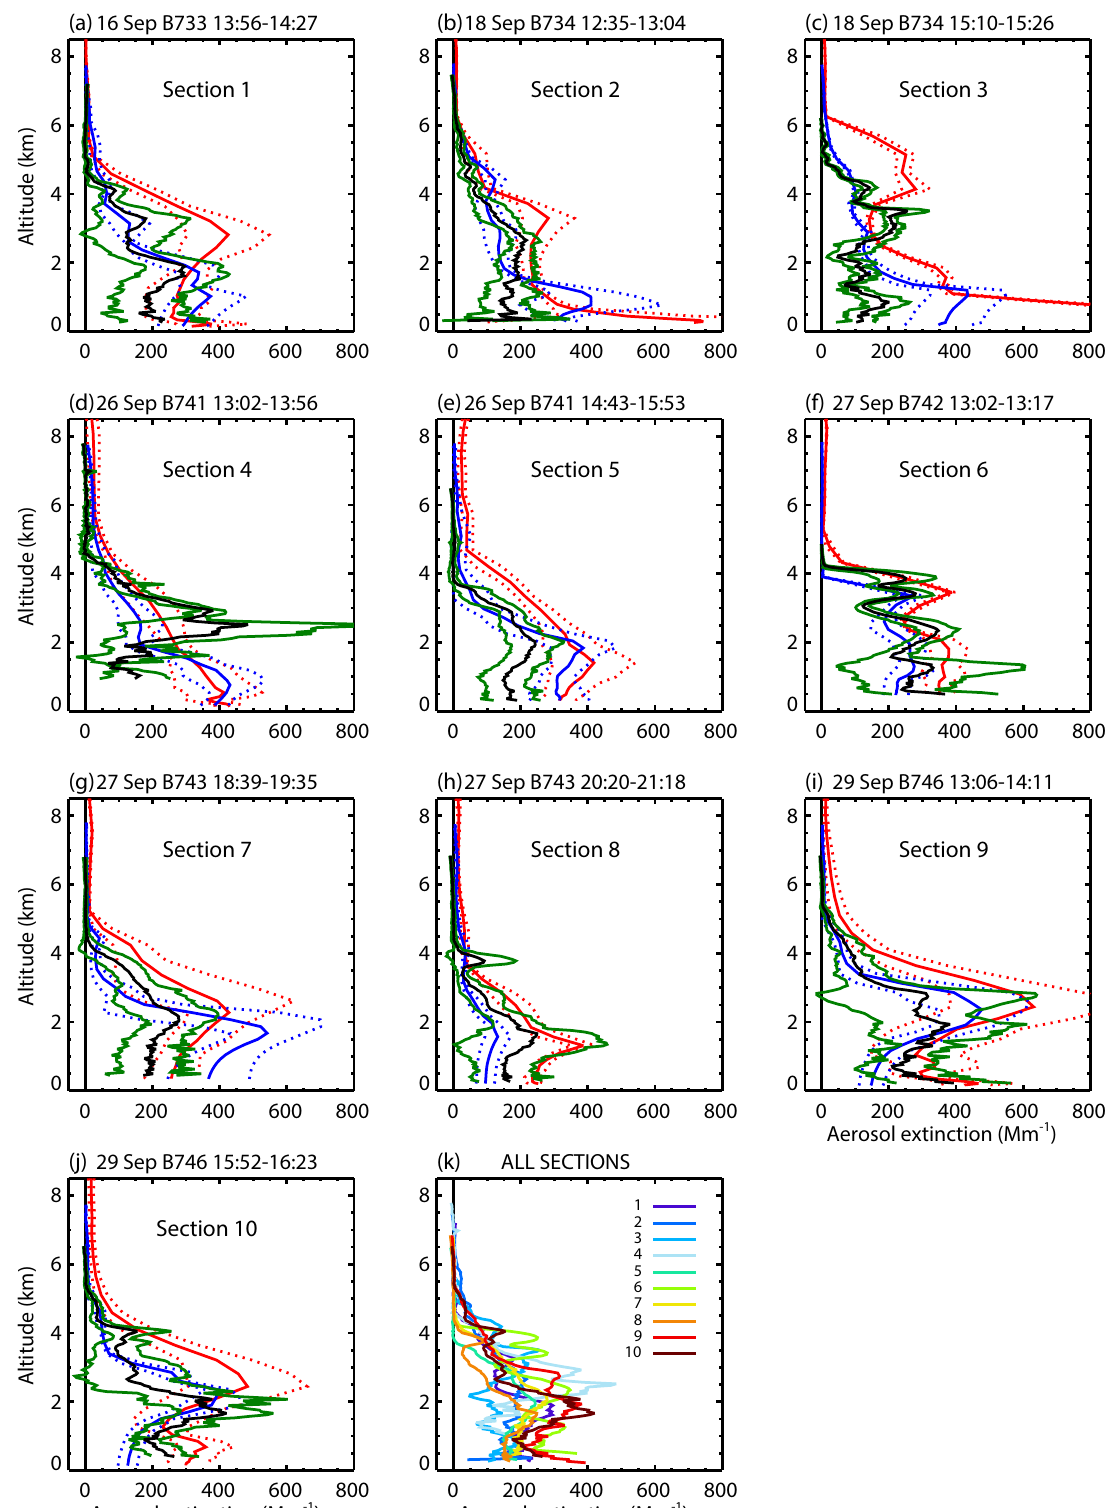
Figure 8. Panels (a–j) : summary vertical profiles for each of the 10 flight sections listed in Table 2. Each plot displays the mean vertical profile (black) and the ± 1 standard deviation curves (green) for the lidar data. The MetUM (blue) and ECMWF-MACC (red) mean vertical profiles and their standard deviation, for each of the sections, are also displayed. Panel (k) : the 10 mean lidar vertical profiles shown in panels (a–j) , each representative of a